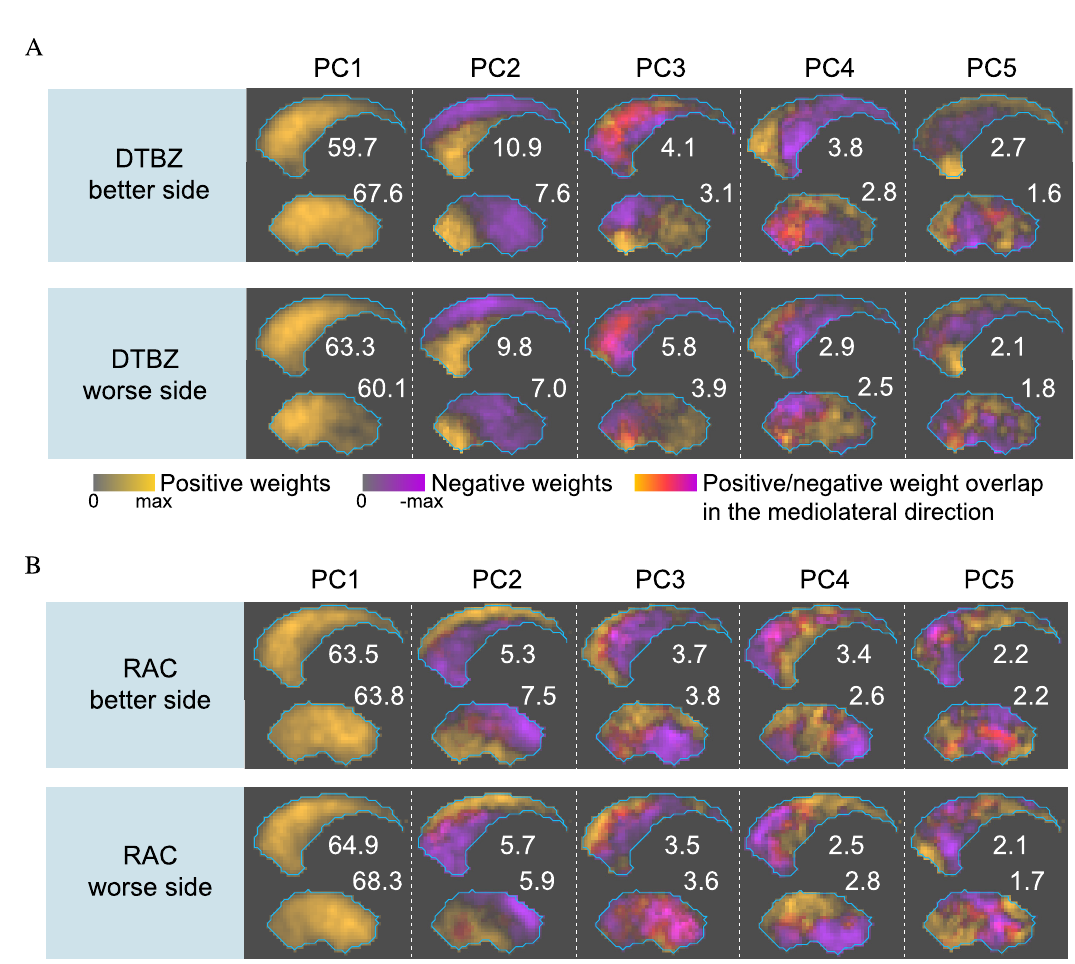
Fig 3. Maximum intensity projections of the better- and worse-side PC loadings, obtained from PCA of all PD subjects. Putamen and caudate loadings were computed separately, and ordered according to VAF expressed in percent. Positive and negative weights were projected separately and combined into a single composite image using different color scales. Color intensity reflects weight magnitude normalized to the maximum absolute value. Loadings with inverted color scales are equivalent. A: DTBZ PC loadings. B: RAC PC